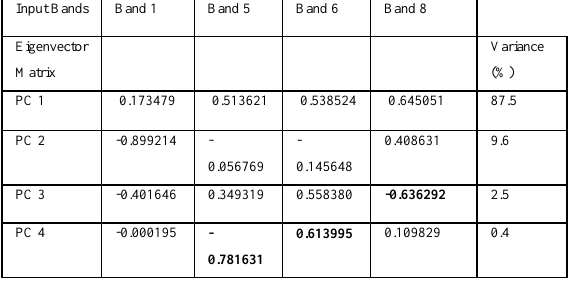
Table 1. Covariance eigenvector values of the FPCS for the selected bands (1, 5, 6, and 8 of ASTER) for Yankari selected subset scene.